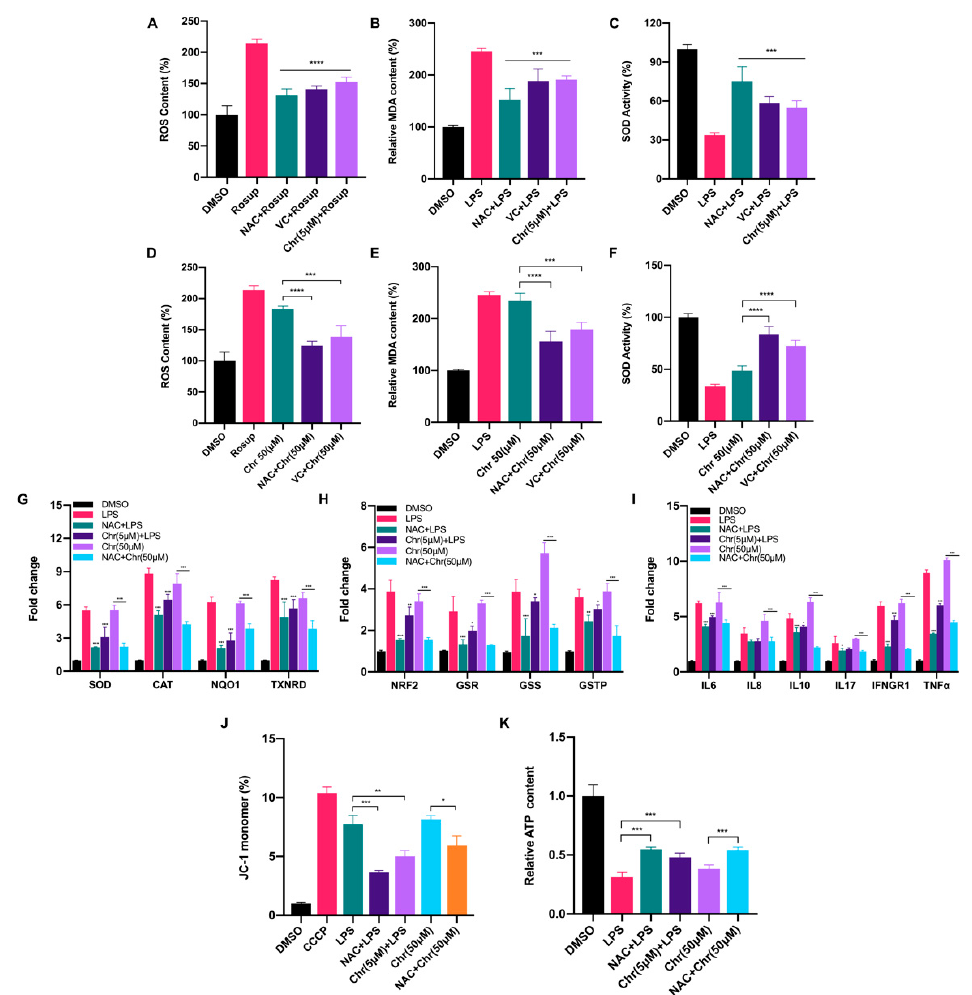
Figure 3. Dual effects of flavonoids on cellular redox biomarkers and relevant gene expression levels. ( A ) The ROS content of different groups. Rosup: 50 µ g/mL for 24 h. NAC + Rosup: pretreated with 5 µ M NAC for 6 h and then 50 µ g/mL Rosup for 18 h. VC + Rosup: pretreated with 500 µ M VC